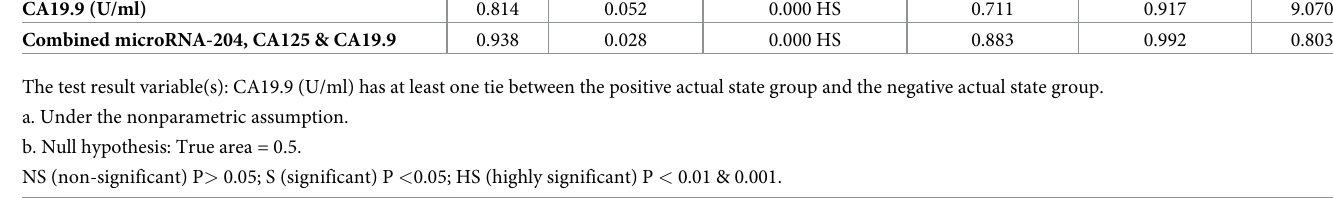
group compared with the control group or in the early group compared with the late group. The pairwise comparisons of the other parameters are shown (S4–S8 Tables). For benign ovarian tumors, the ROC curves describing the diagnostic performance of microRNA-204, CA125, and CA19.9 and the area under the curve (AUC) revealed that micro- RNA-204 exhibited a weak diagnostic performance with an AUC of 0.553 (p > 0.05) and a cut-off value of 0.248. CA125 exhibited a high diagnostic performance with an AUC of 0.931 (p < 0.001) and a cut-off value of 26.130. CA19.9 exhibited a high diagnostic performance with an AUC of 0.814 (p < 0.001) and a cut-off value of 9.070. The combination of microRNA-204, CA125, and CA19.9 showed the highest diagnostic performance with an AUC of 0.938 (p < 0.001) and a cut-off value of 0.803 (Table 3 and Fig 1). For early ovarian cancer patients, microRNA-204, CA125, and CA19.9 showed high diag- nostic performances with AUCs of 0.924, 0.926, and 0.914, respectively (p < 0.001) and cut-off values of 0.542, 46.440, and 9.015, respectively. The combination of microRNA-204, CA125, and CA19.9 showed the highest diagnostic performance with an AUC of 1.000 (p < 0.001) and a cut-off value of 0.500 (Table 4 and Fig 2). For late ovarian cancer patients, microRNA-204, CA125, and CA19.9 showed high diagnos- tic performances with AUCs of 0.942, 0.980, and 0.918, respectively (p < 0.001) and cut-off values of 1.390, 39.030, and 11.820, respectively. The combination of microRNA-204, CA125, and CA19.9 showed the highest diagnostic performance with an AUC of 0.998 (p < 0.001) and a cut-off value of 0.742 (Table 5 and Fig 3).